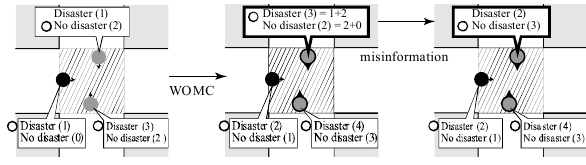
Figure 15. Model of false information